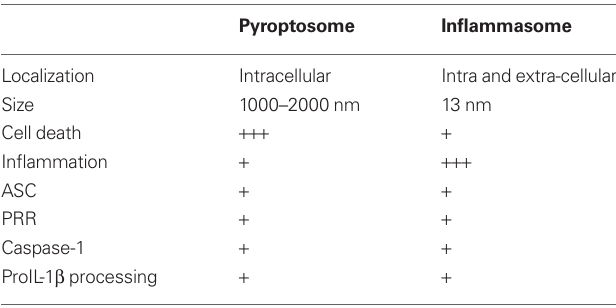
Table 1 | Pyroptosome versus